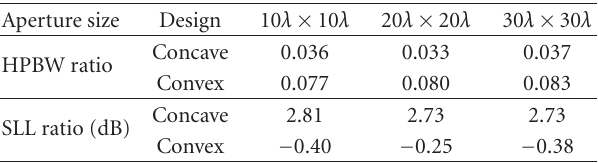
Table 1: Change in Radiation Performance of Conformal Cylindri- cal Reflectarrays with D/ R c =